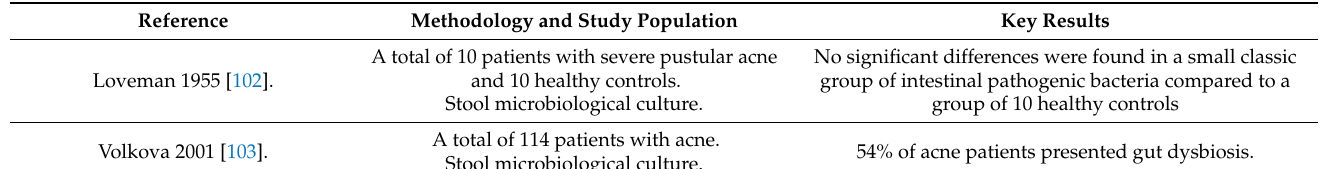
Table 1. Main studies including gut microbiota data in patients with and acne